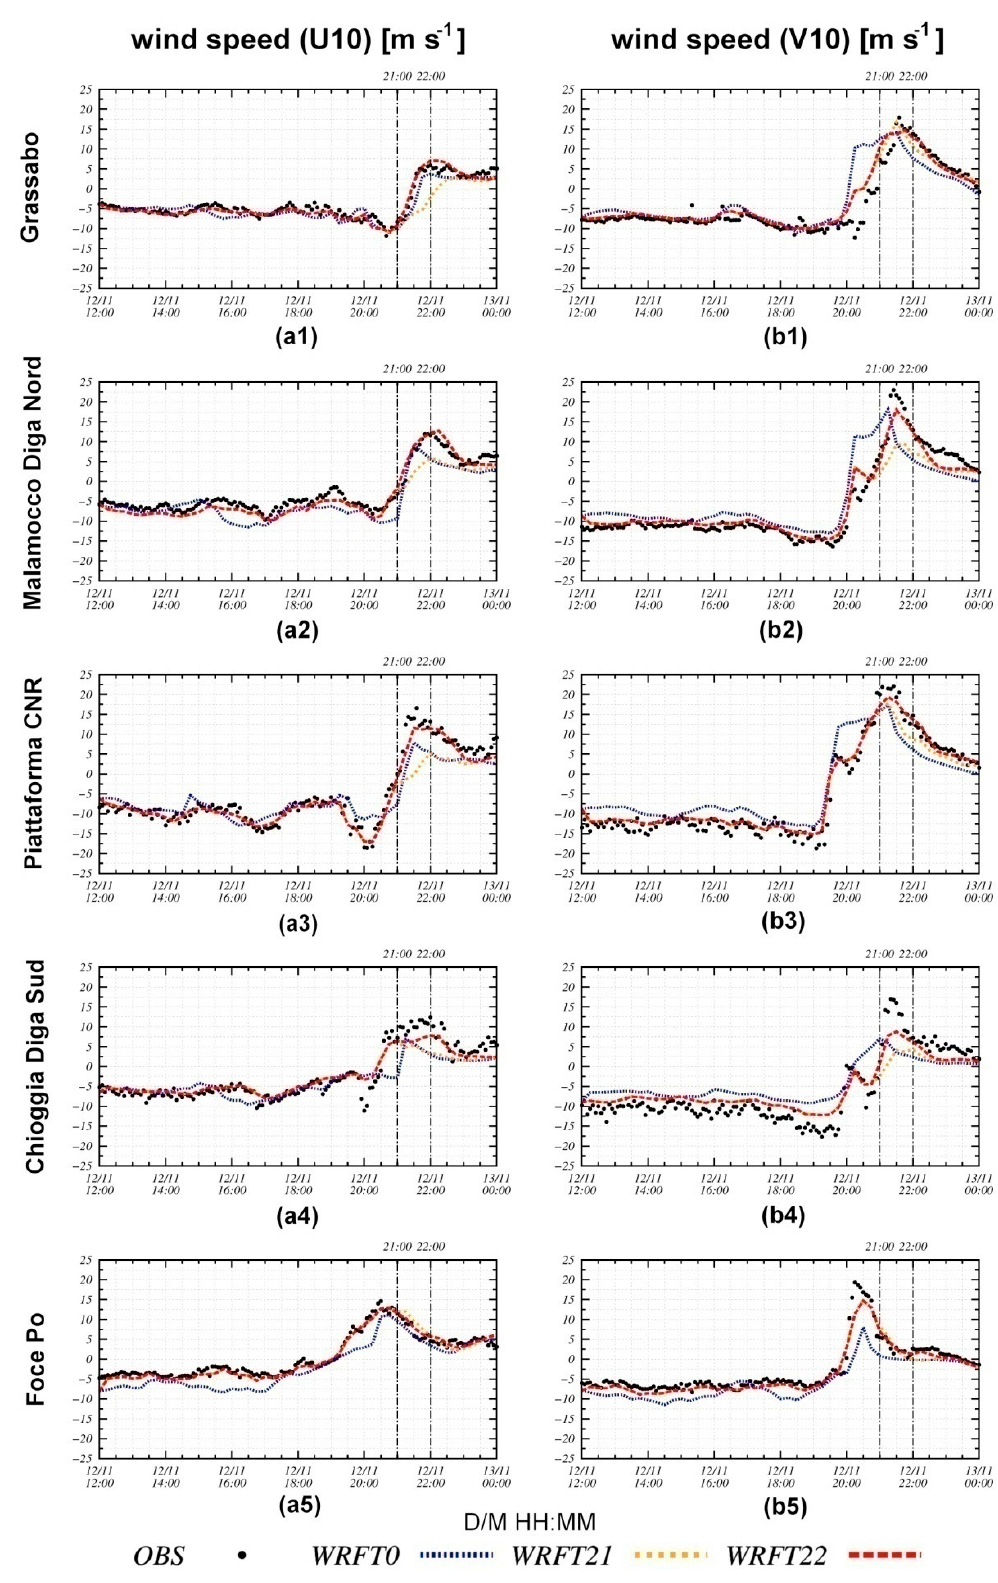
Figure 9. The zonal (left panels) and meridional (right panels) wind components (m · s − 1 ) for a selection of weather stations (one for each row), sorted from north to south. Black dots represent the observed values. The blue, orange, and red lines show the values extracted from the inner grid (3 km) of the control run, and the runs with data assimilation until 21:00 UTC and 22:00 UTC on 12 November 2019, respectively.